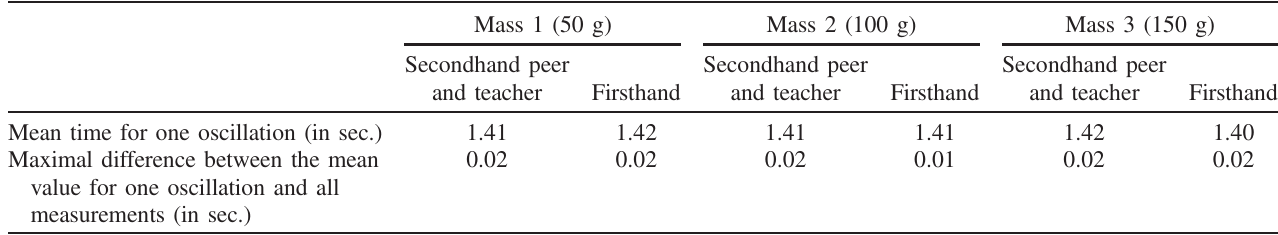
TABLE II. Correct solution of the analysis of the datasets.